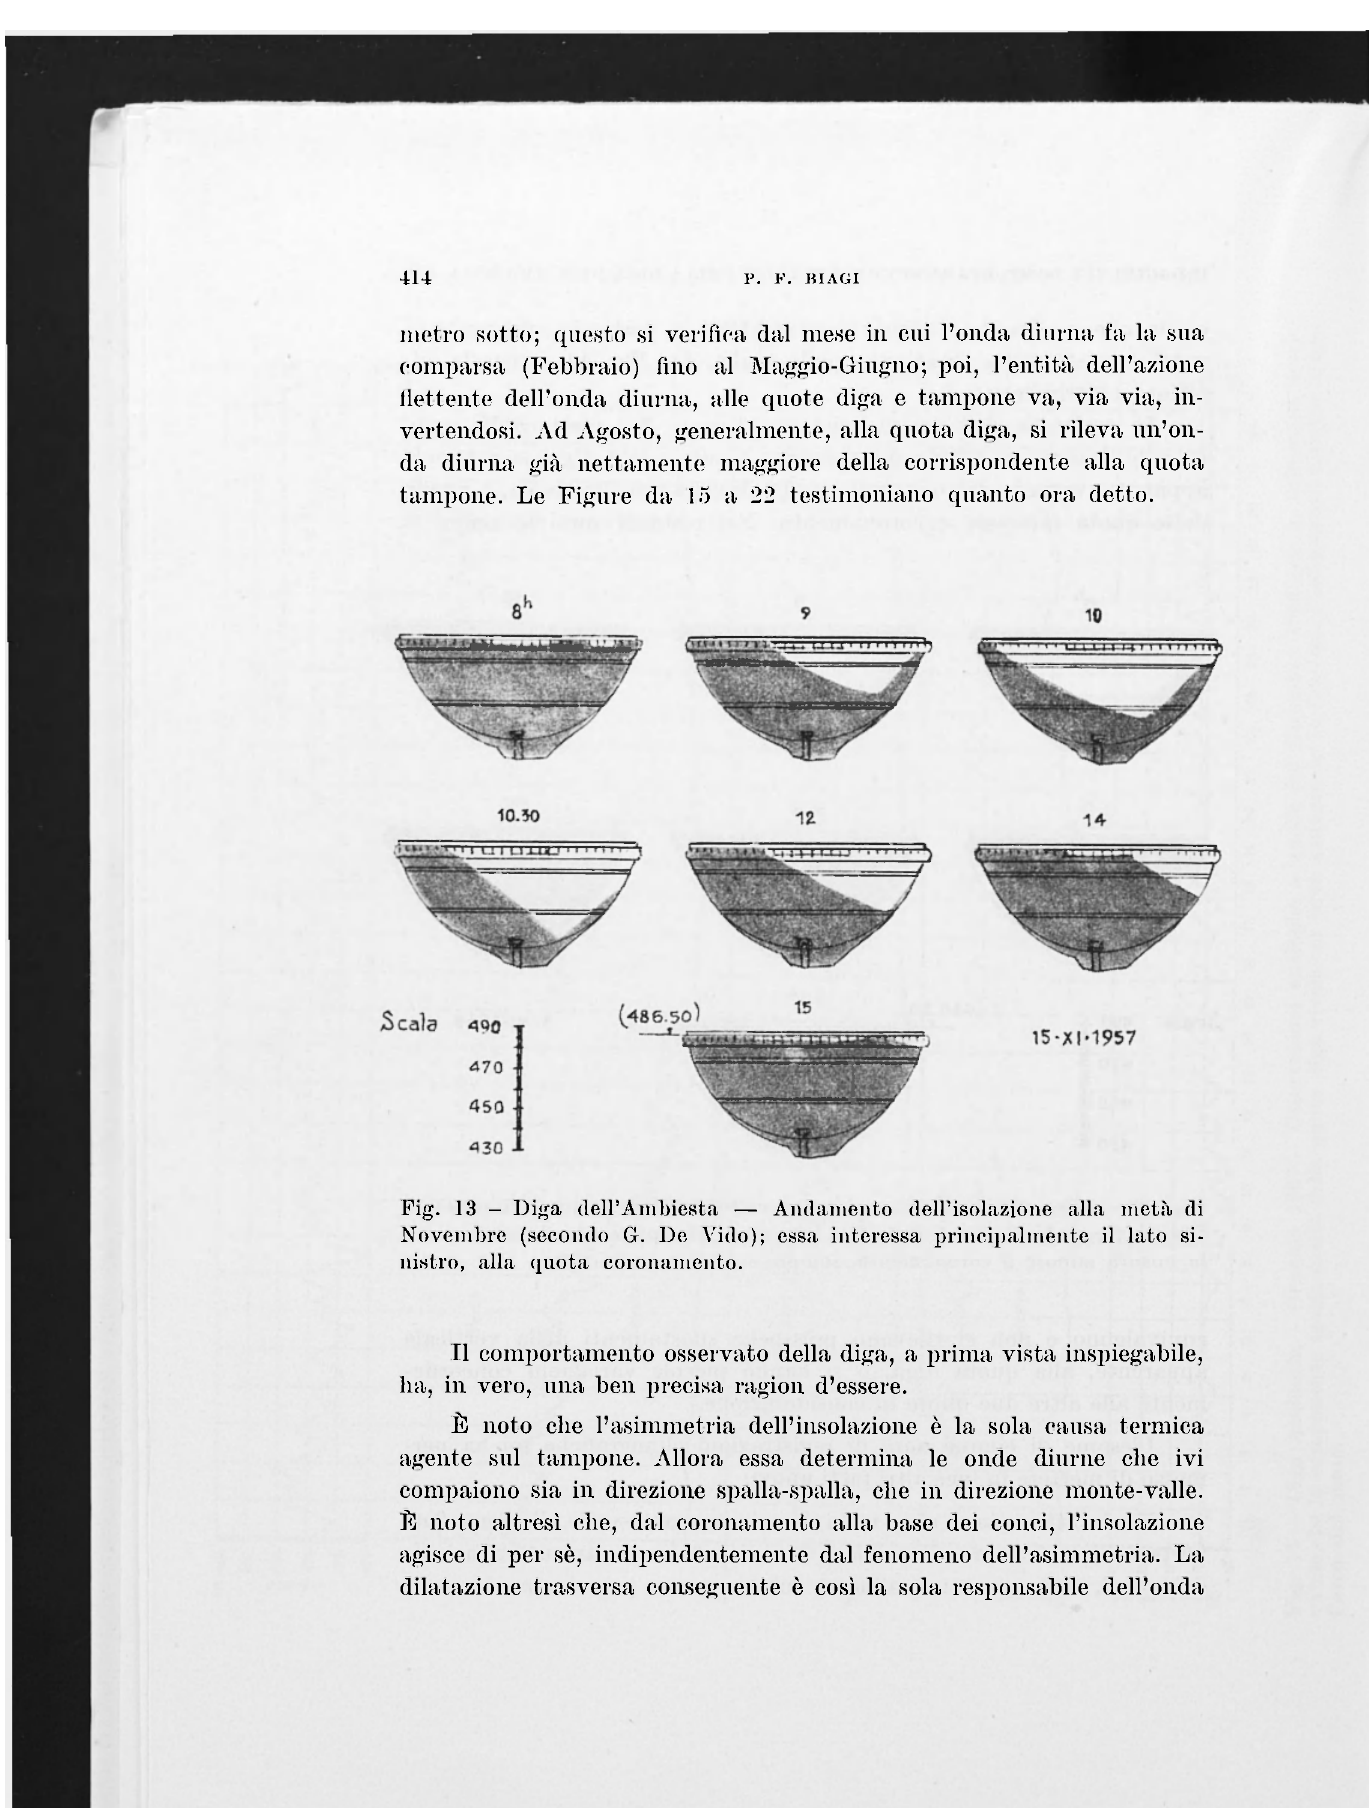
Fig. 13 - Diga dell'Ambiesta — Andamento dell'isolazione alla metà di Novembre (secondo G. Do Vido); essa interessa principalmente il lato si- nistro, alla quota